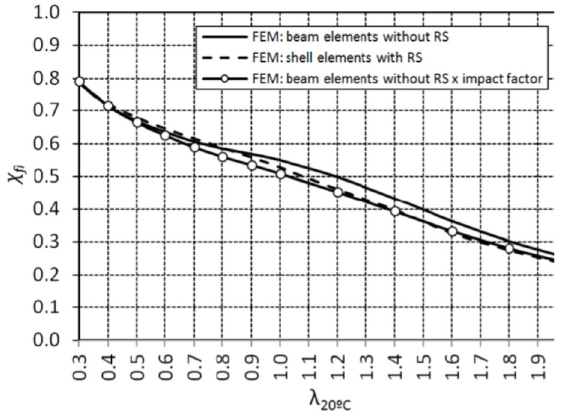
Fig. 6. Buckling factors for models with residual stresses, without residual stresses and models adjusted with impact factor (HEA500, t = 900 ° C, S355, strong